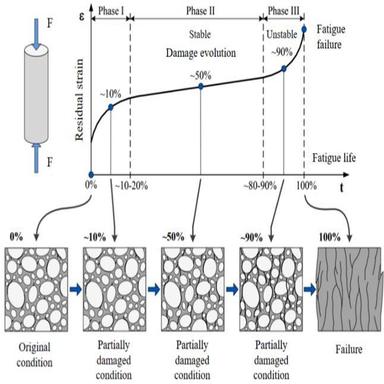
Illustration of the fatigue damage evolution under compressive fatigue loading adapted from .